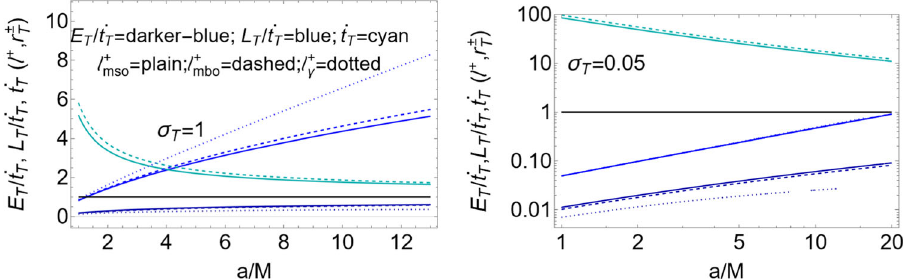
Fig. 5 Analysis of the counter-rotating flows inversion points r ± (cid:2) of Eq. (9) with fluid specific angular momentum (cid:6) + < 0 of the plane σ ≡ sin 2 θ , for different NS spin-mass ratios signed on the panels, where σ = 1 is the equatorial plane. Notation ( mso ) is for quantities evaluated on the marginally stable orbit, ( mbo ) refers to the marginally